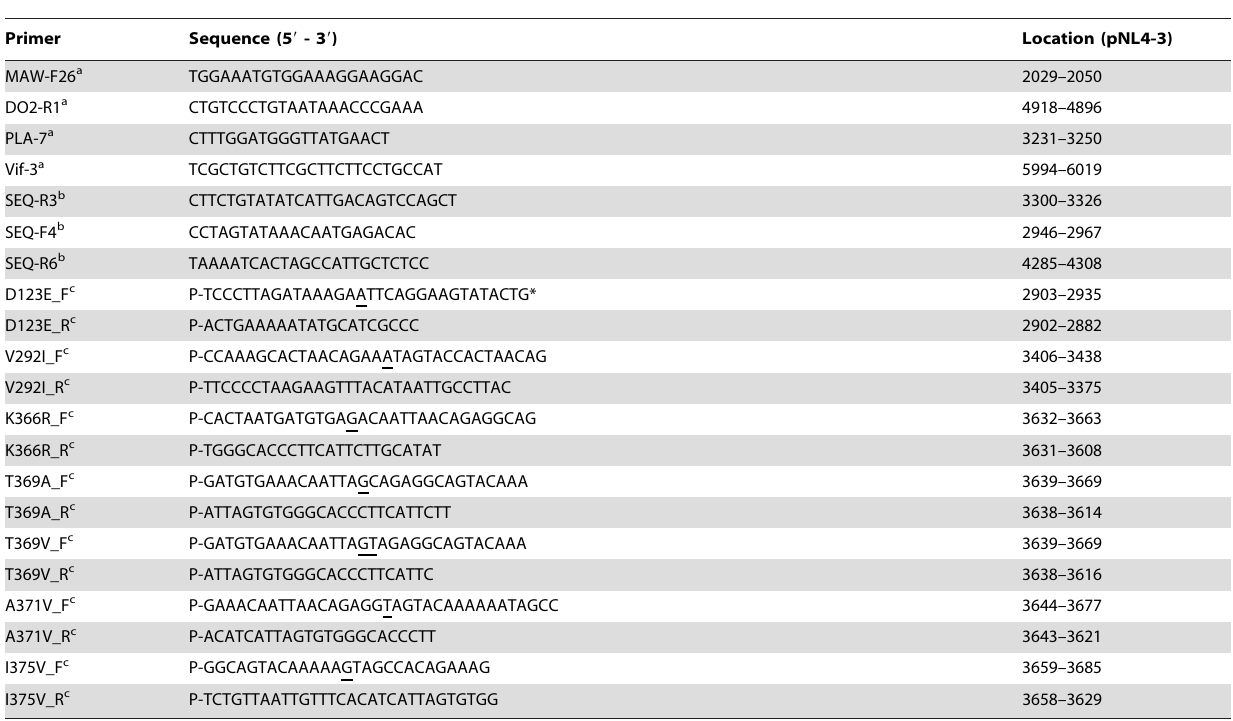
Table 4. Primers of the site-directed